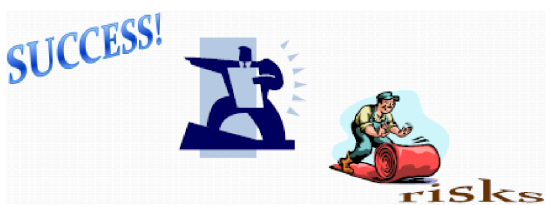
Figure 4. Current state of the art highlights success while often denying